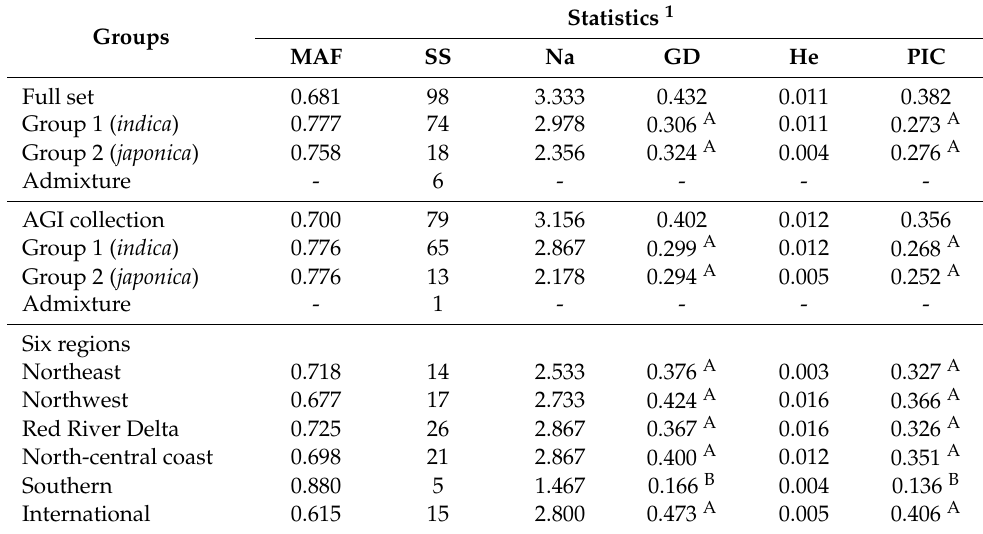
Table 3. The average number of alleles, GD, and PIC for different subgroups/regions. Groups